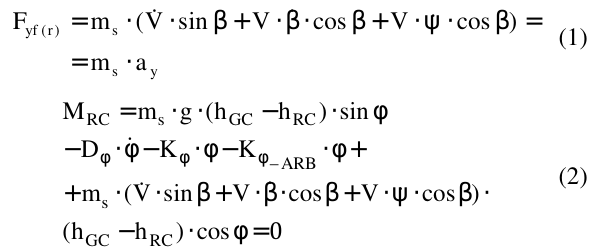
Fig. 2. The angle of wheel camber g as a function of vehicle body roll angle f for different types of suspension (including the impact of tire deflection) [own research]